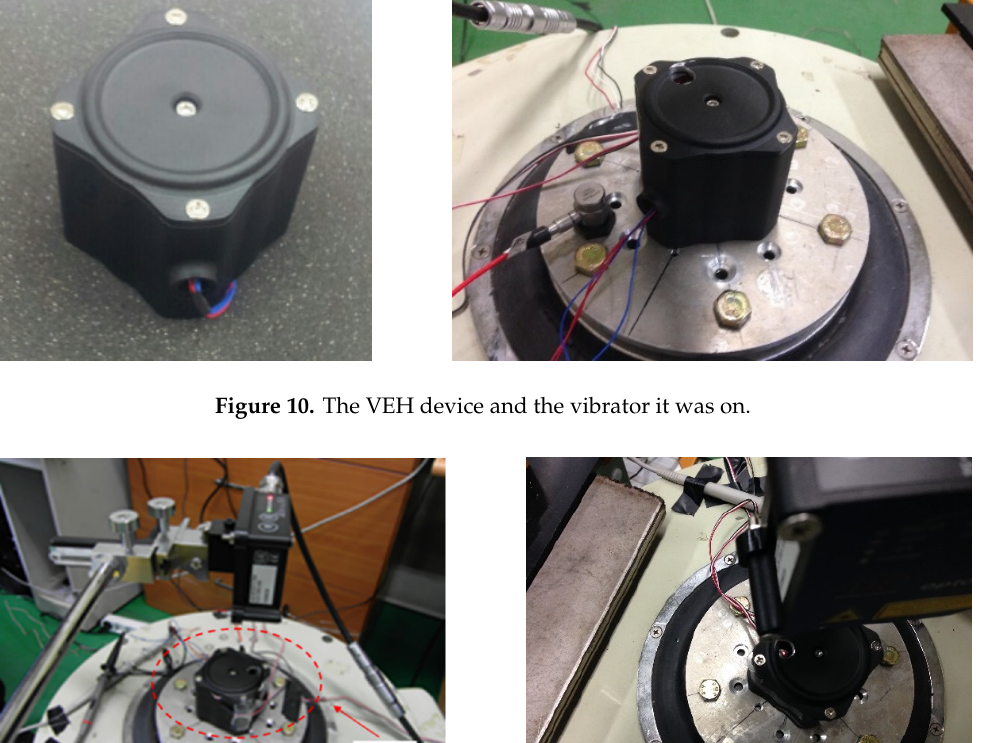
Figure 12. The test results of the moving displacement for the spring according to the vibration acceleration at one lower coil of the VEH device. The VEH device with a resonant frequency of 50 Hz was tested to increase the frequency by 1 Hz in the 50 Hz ± 5 Hz frequency band under 0.5, 1.0 and 2.0 G vibration acceleration conditions. The thickness of the spring was 1.0 mm. The maximum moving displacement of spring was 4.0 mm.